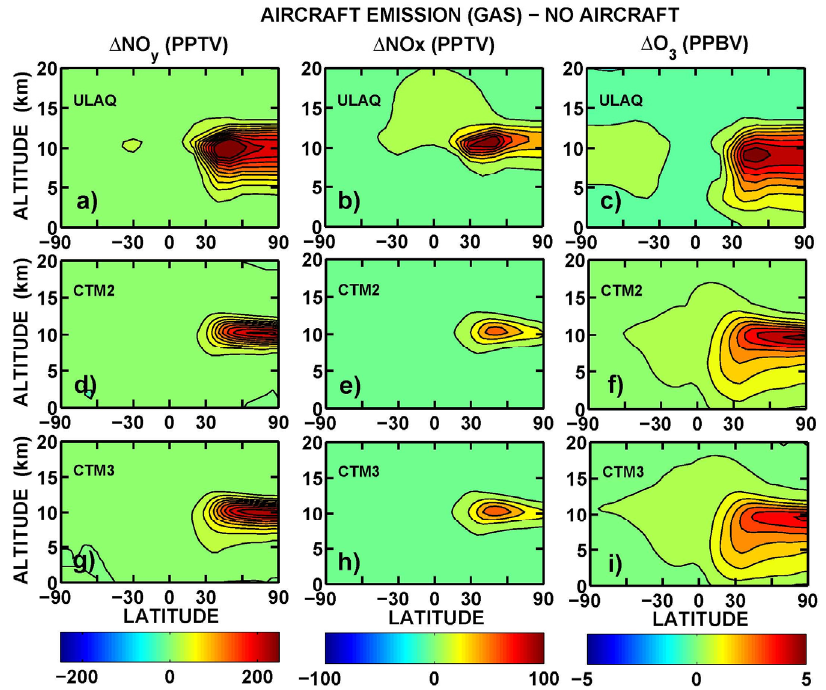
Figure 7. Zonally and annually averaged changes produced by gaseous aircraft emissions (AE-NA) of NO y (left panels), NO x (mid panels) and O 3 (right panels), for ULAQ, CTM2 and CTM3 models, from upper to lower panels, respectively. Black contours are shown every 25 pptv for NO x and NO y , and 0.5 ppbv for O 3